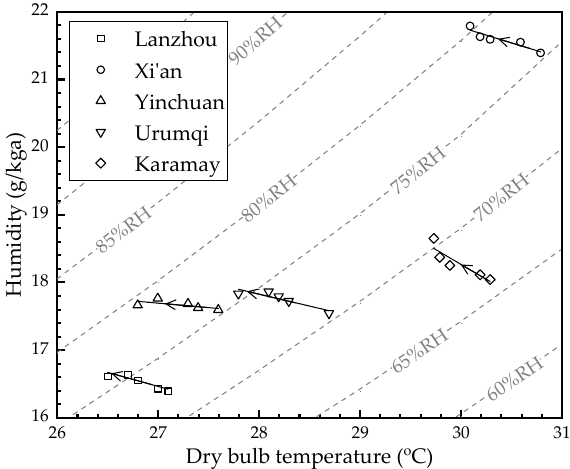
Figure 6. The air outlet parameters of the HFMEC in each city under different water flow rates.